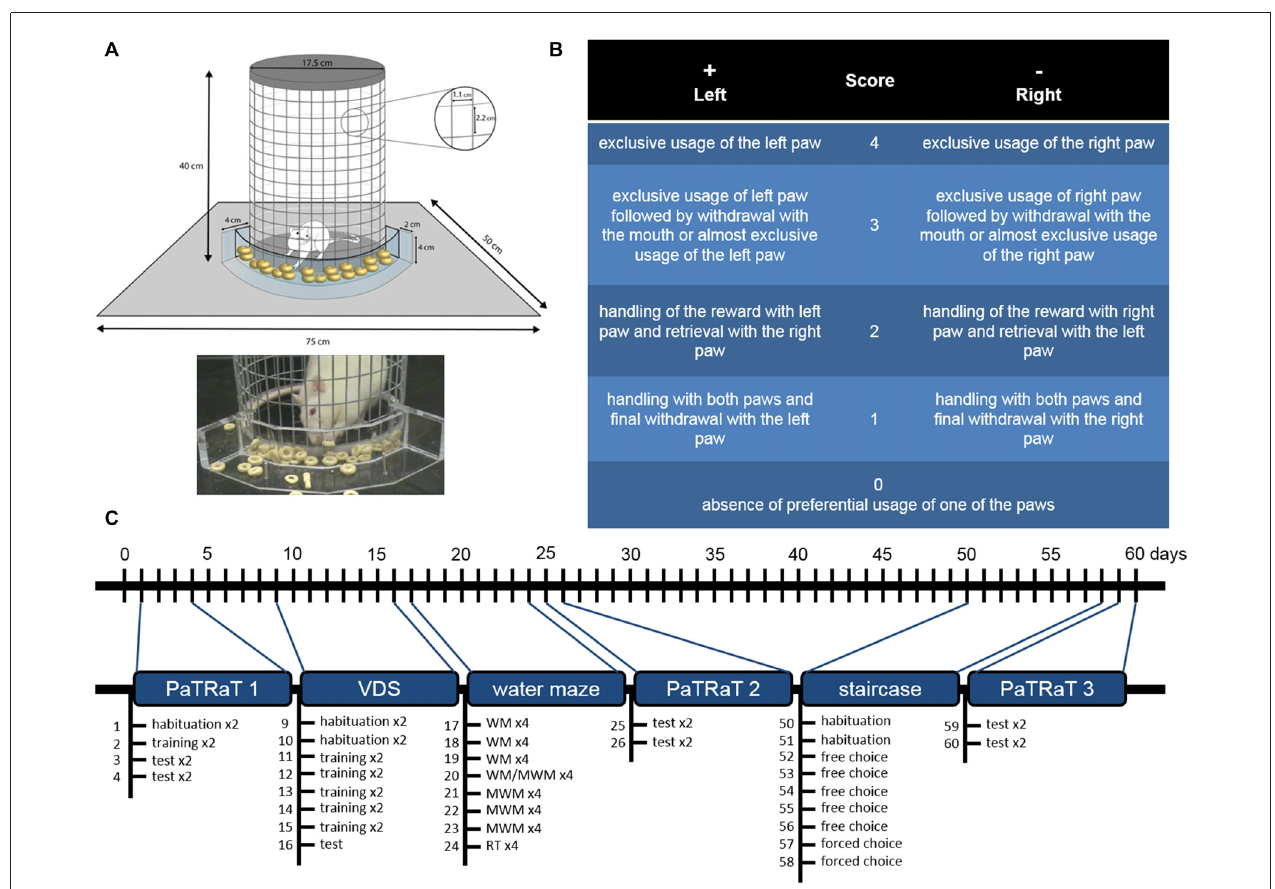
FIGURE 1 | Methods. (A) Scheme (top) and picture (bottom) depicting the pawedness apparatus. The animal is enclosed in a gridded cylinder. An exterior plexiglass structure contains the rewards. (B) Schematic table of classification for each retrieved reward. Positive and negative values correspond respectively to preferential usage of left and right paw and higher values are associated to more exclusive usage of said paw. (C) Timeline of behavioral analysis. Pawedness was assessed three times approximately 4 weeks apart. VDS and water mazes were performed between the two first evaluations and staircase test was performed before the third pawedness evaluation. Individual sessions are specified. VDS, Variable Delay-to-Signal; WM, working memory; MWM, Morris Water Maze; RT, reversal